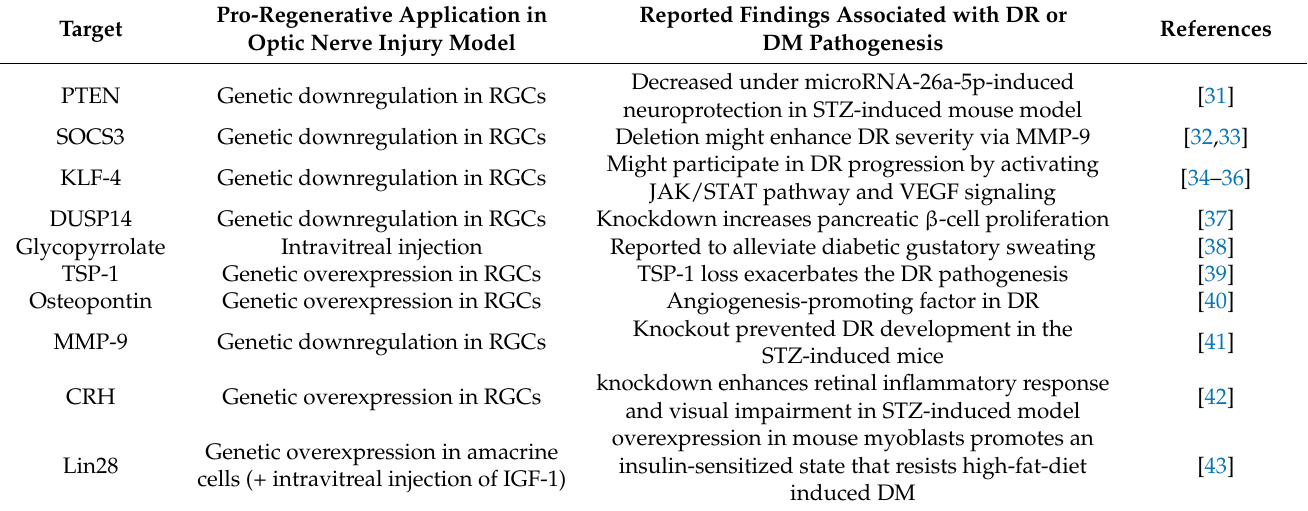
Table 1. Reported DR-related findings of pro-regenerative targets under optic nerve injury